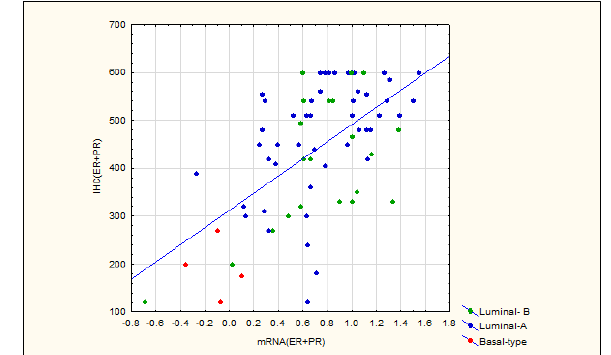
Combined oestrogen (ER) and progesterone receptor (PR) scores for immunohistochemistry (IHC) (0–600) and TargetPrint (-2 to +2), in relation to tumour molecular subtype determined using